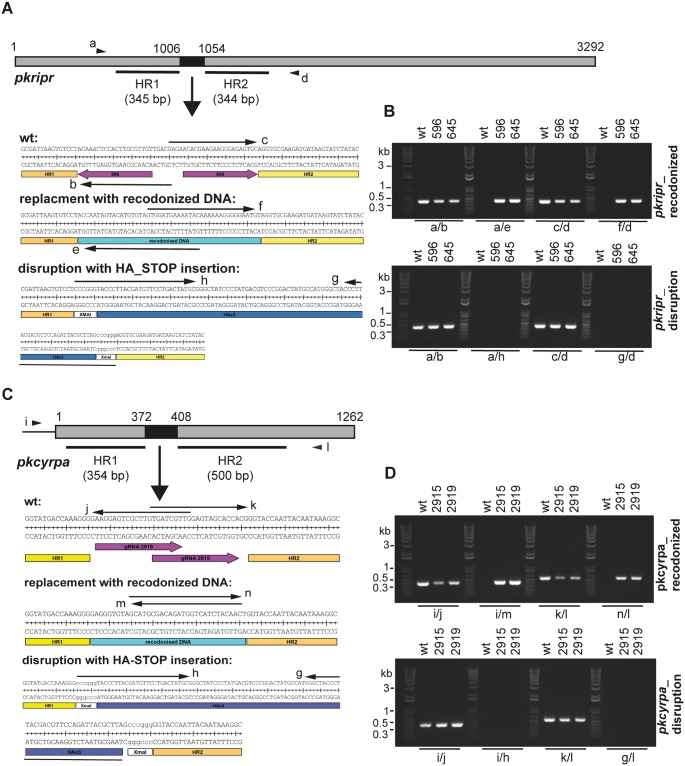
RIPR and CyRPA are essential for P. knowlesi parasite growth.Schematics of disruption approaches for ripr (A) and cyrpa (C) in P. knowlesi, respectively. ORFs are depicted, indicating regions used as homology regions (HR) in repair plasmids. Black boxes represent endogenous DNA sequence (bp 1006–1054 (ripr) and 372–408 (cyrpa)) which was replaced either by recodonized DNA or by a triple HA-tag followed by a stop codon. Sequence details are given in the corresponding boxes below, of endogenous (wild type), recodonized DNA or HA-STOP regions. Primers used in PCR to genotype transfectants are indicated by arrows. B) Genotyping of PkA1-H.1 transfections with pGEMT-PkRIPRko or pGEMT-PkRIPRrecodonized with pDC596 and pDC645 Cas9/guide plasmids. D) Genotyping of PkA1-H.1 transfections using pGEMT-PkCyRPAko or pGEMT-PkCyRPArecodonized together with Cas9/guide plasmids pDC2915 or pDC2919. Primers for genotyping (S2 Table) were as follows: a, PKRIPRkoextFor; b, PKRIPRintRev; c, PKRIPRintFor; d, PKRIPRkoextRev; e, PKRIPRkorecRev; f, PKRIPRkorecodFor; g, HArev(Xma); h, HAfor(Xma); i, PKCyRPAextFor; j, PKCyRPAintRev; k, PKCyRPAintFor; l, PKCyRPAextRev; m, PKCyRPArecodRev; n, PKCyRPArecodFor. Expected PCR product sizes for Pkripr are: a/b = 426 bp; a/e = 434 bp; c/d = 412 bp; f/d = 418 bp; a/h = 509 bp; g/d = 499 bp. Expected PCR product sizes for Pkcyrpa are: i/j = 425 bp; i/m = 438 bp; k/l = 566 bp; n/l = 570 bp; i/h = 504 bp; g/l = 654 bp.